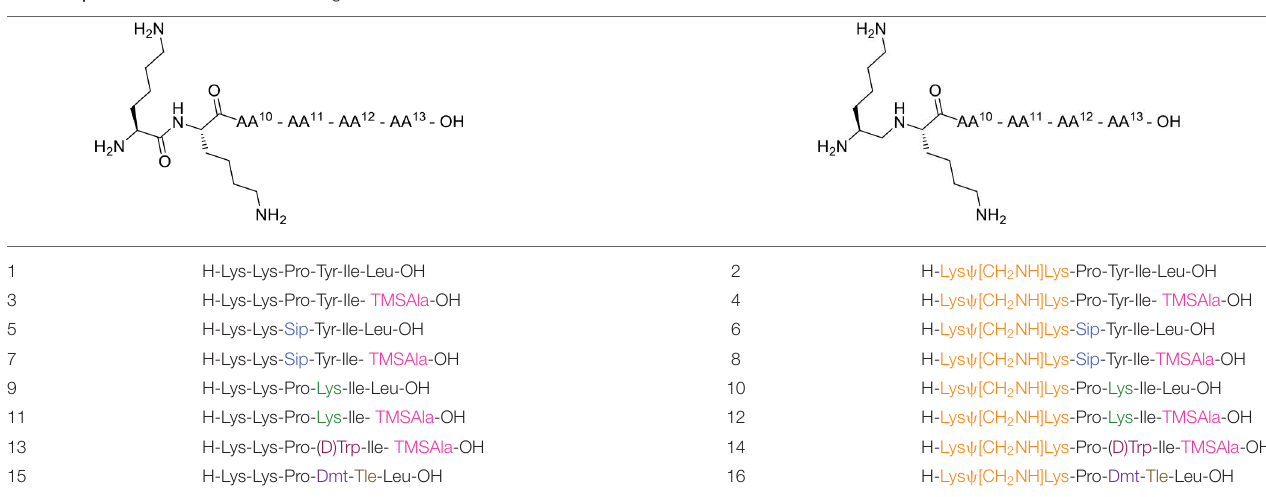
TABLE 1 | Chemical structures of NT analogs.